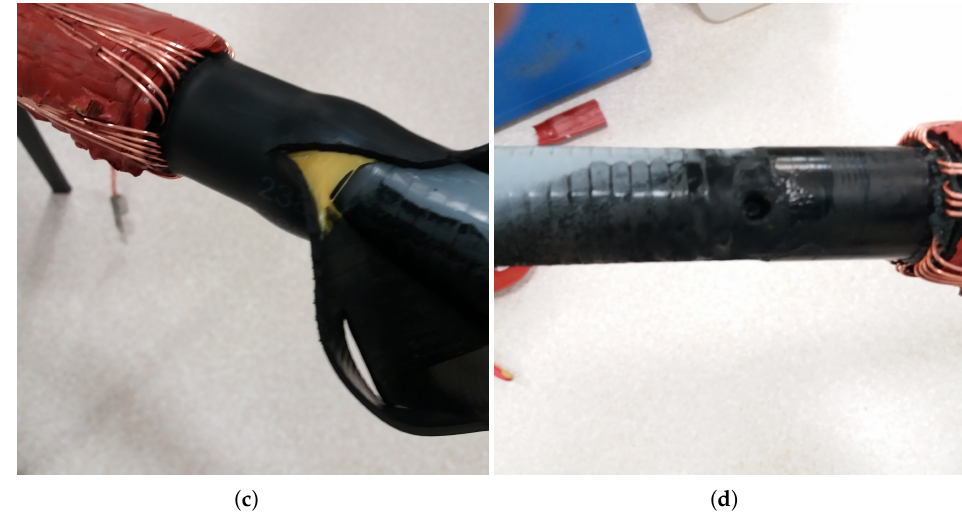
Figure 12. Damage to the surface of the insulation and the shield of the XRUHAKXS 1 × 240/25 cable at the MV cable termination: ( a ) disassembly of the insulating pipe RART 49/16-450, ( b ) disassembly of the control tube RSCT 47/14-160, ( c ) disassembly of the control strap EP STRESS 20, ( d ) view of damage to XLPE insulation